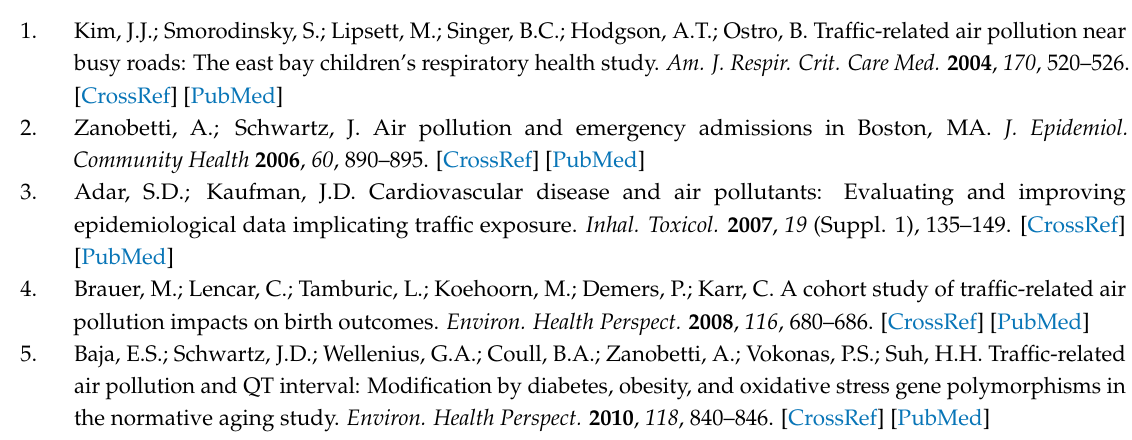
Figure S1: Study site and monitoring locations, Table S1: Season- and traffic volume-stratified correlation coefficients of traffic-related metrics with measured black carbon concentrations in different near-road